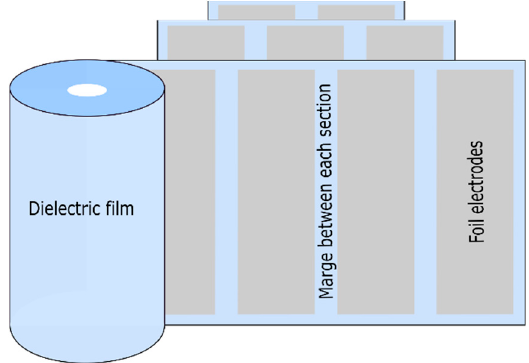
Figure 6. A multisection foil–film capacitor [19].